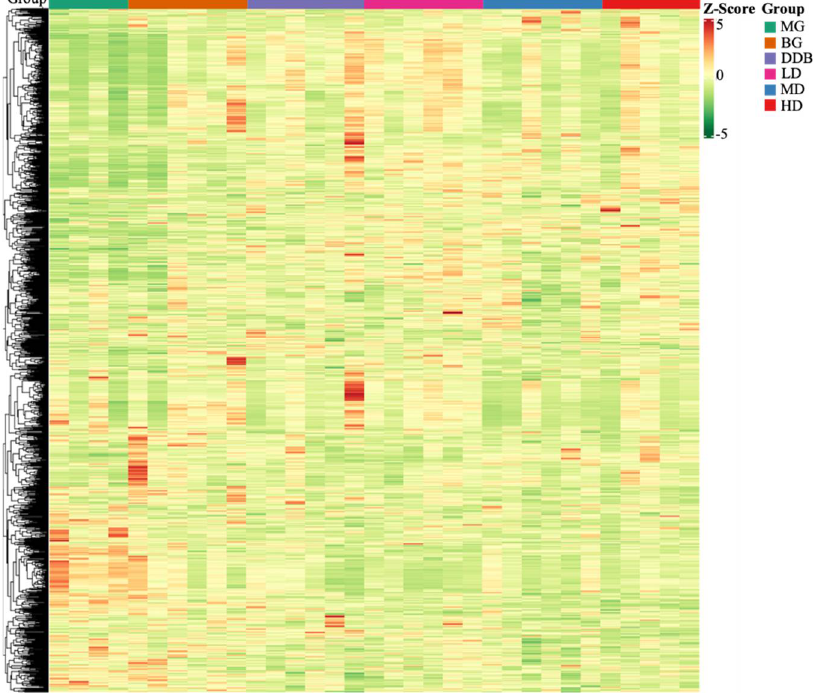
Figure 7. Heat map. The x-axis represents groups, and the y-axis represents differentially ex- pressed genes. Data (peak areas) were normalized between − 5 and 5 (green—the lowest level; red—the highest